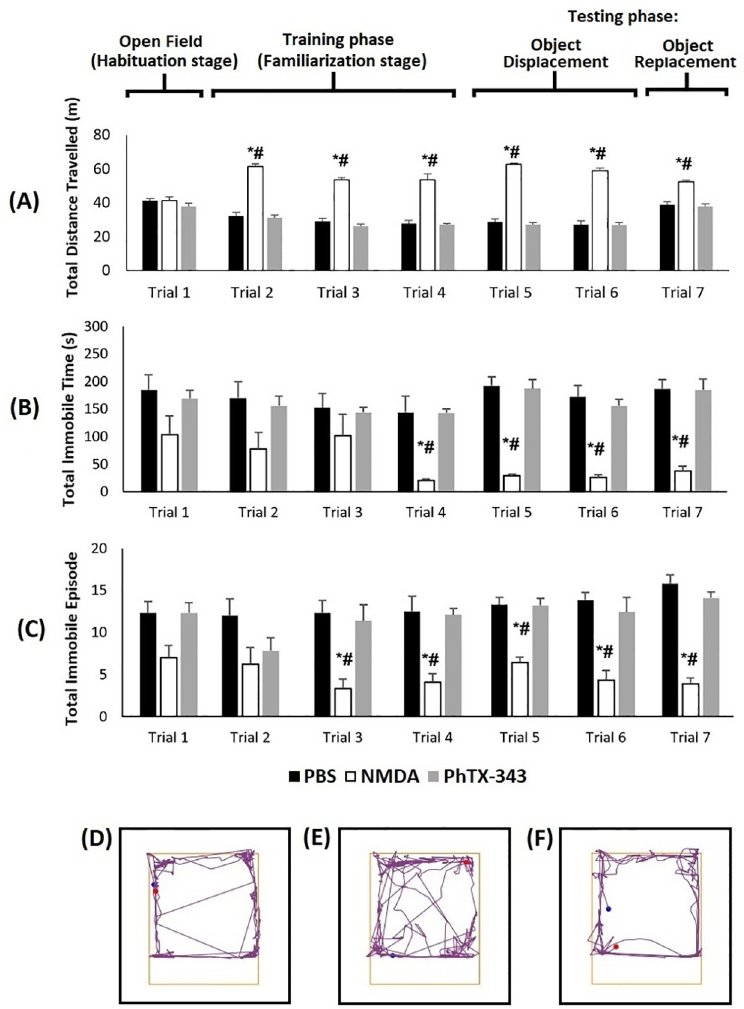
Fig 5. Effects of PhTX-343 on exploratory and locomotor activities using open field test in NMDA-induced rats. (A) Total distance travelled, (B) total immobile time, and (C) total immobile episodes, recorded by the rats for each group. Examples of track plots for each group are also displayed: (D) PBS, (E) NMDA, and (F) PhTX-343 groups respectively. Statistical significance was conferred using Kruskal-Wallis test with Bonferroni correction: � p < 0.05 versus PBS; #p < 0.05 versus